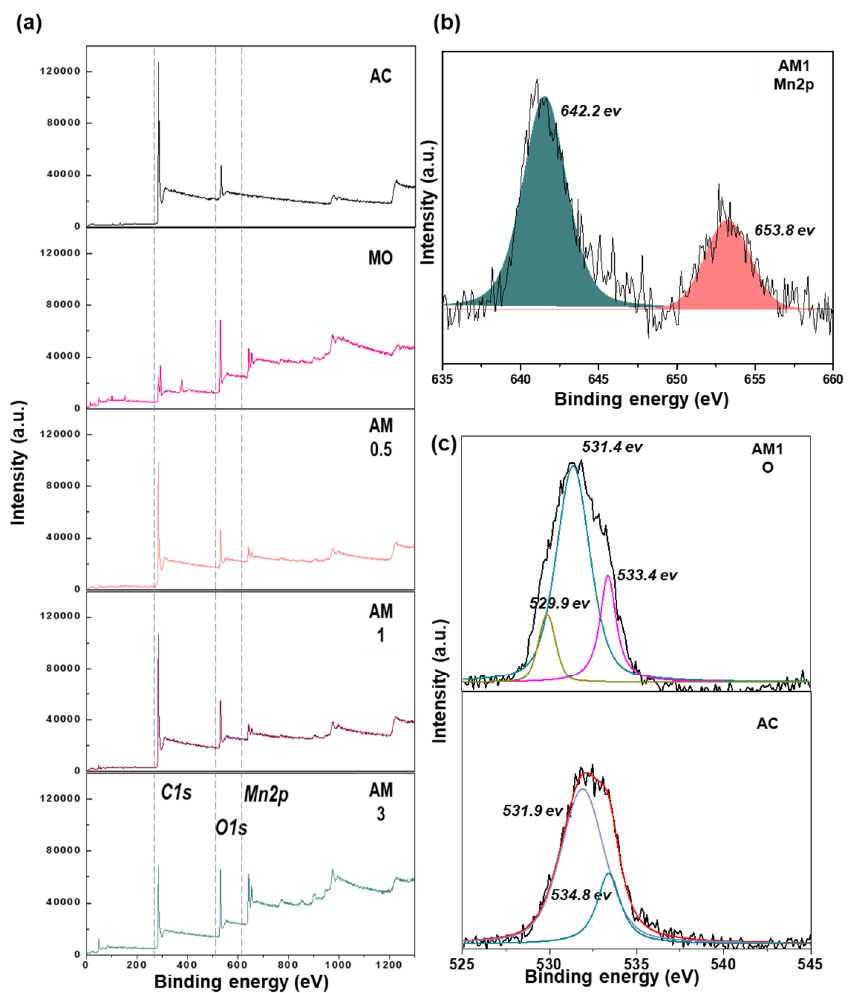
Figure 1. X-ray photoelectron spectroscopy spectra of AC, MO and AM composites: ( a ) survey scan; ( b ) Mn2p spectrum; and ( c ) O spectrum of AM1 composites. Table 1. Elemental properties of the as-synthesized samples. X-ray Photoelectron Spectroscopy (at. %) ICP-OES (at. Sample